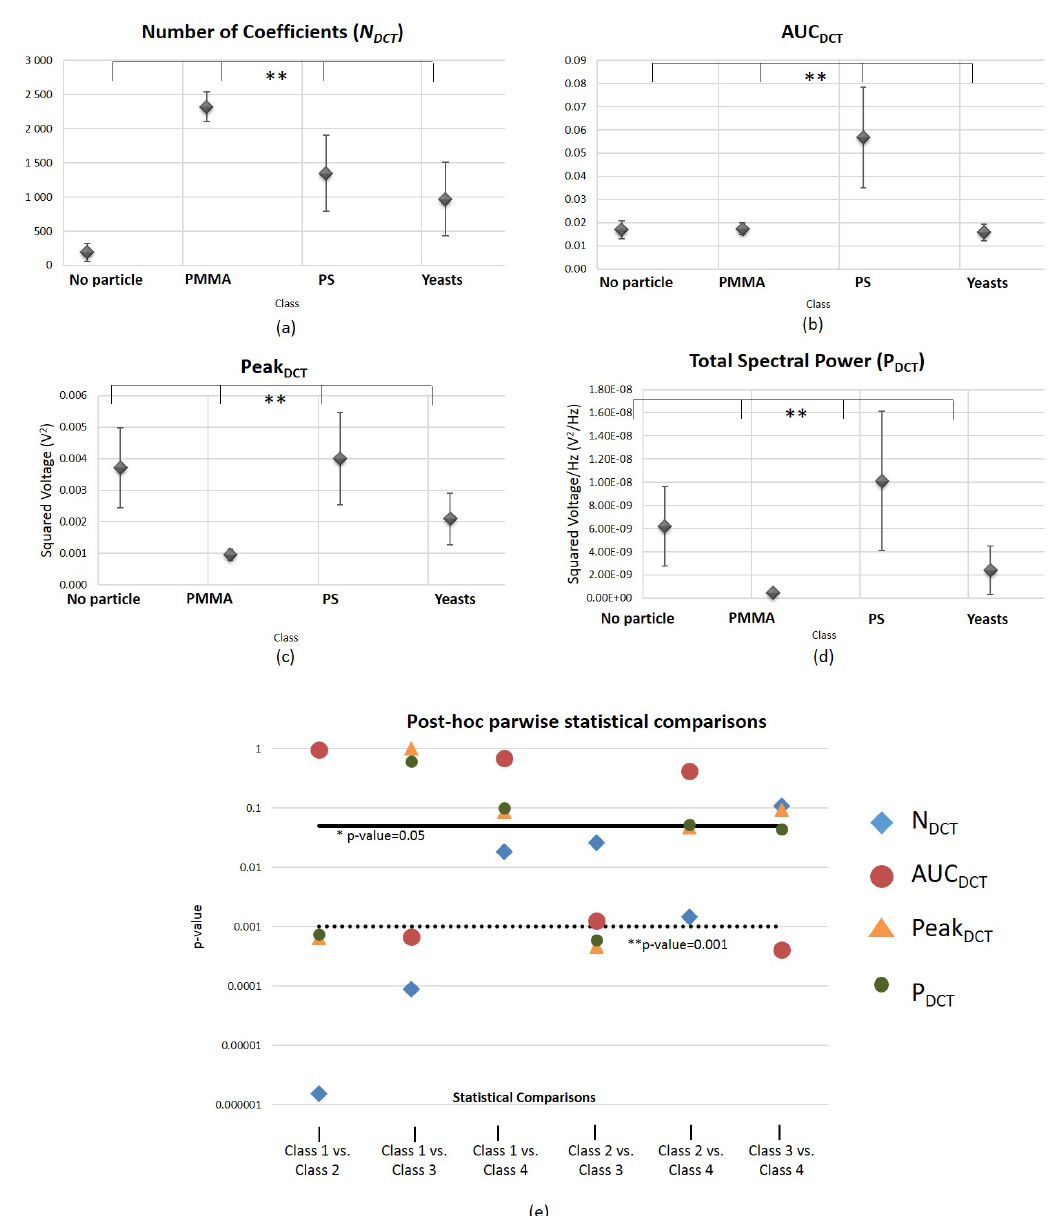
Figure 10. Graphical representation of the results obtained regarding the statistical comparisons performed using DCT-derived features for ( a ) Number of DCT coefficients that capture 98% of the total amount of energy of the original back-scattered signal (4 classes comparisons, Kruskal-Wallis test); ( b ) Total AUC of the DCT spectrum for the entire range of frequencies (4 classes comparisons, Kruskal-Wallis test); ( c ) Amplitude of the DCT spectrum peak for all range of frequencies analyzed (4 classes comparisons, Kruskal-Wallis test); ( d ) Total DCT spectral power (4 classes comparisons, Kruskal-Wallis test). The error bars represent standard error values. ** p < 0.001. * p < 0.05. ( e ) p -values obtained in the post hoc parwise statistical comparisons performed after Kruskal-Wallis for each one of the DCT-derived parameters evaluated, using the Mann Whitney test. Vertical axis is in logarithmic scale. Class 1—“no particle trapped”; Class 2—“PMMA particle trapped”; Class 3—”Polystyrene particle trapped”; Class 4—“Living yeast cell trapped”. N No particle = 18; N PMMA = 16; N PS = 18; N Yeasts =